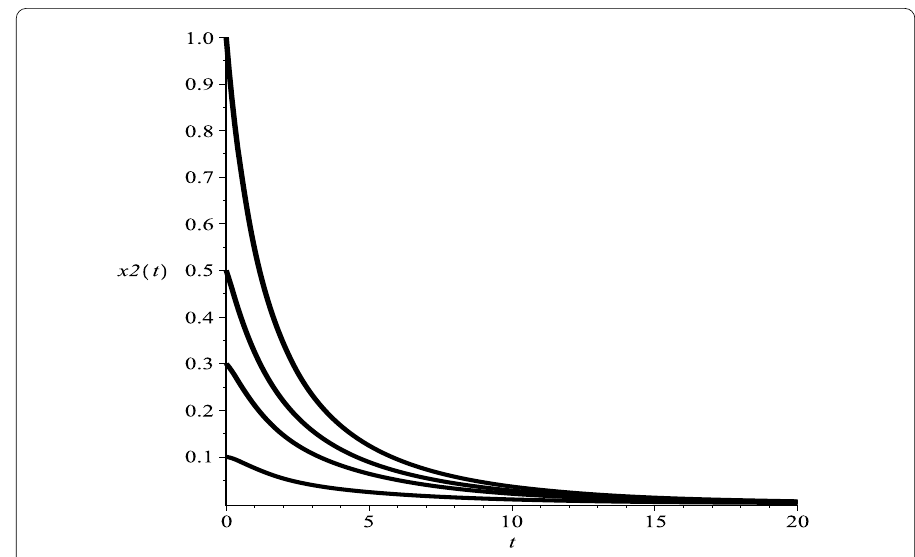
Figure 3 ynamic behaviors of the second component x 2 ( t ) of system (4.1), here we take d = 1/4 and the initial conditions ( x